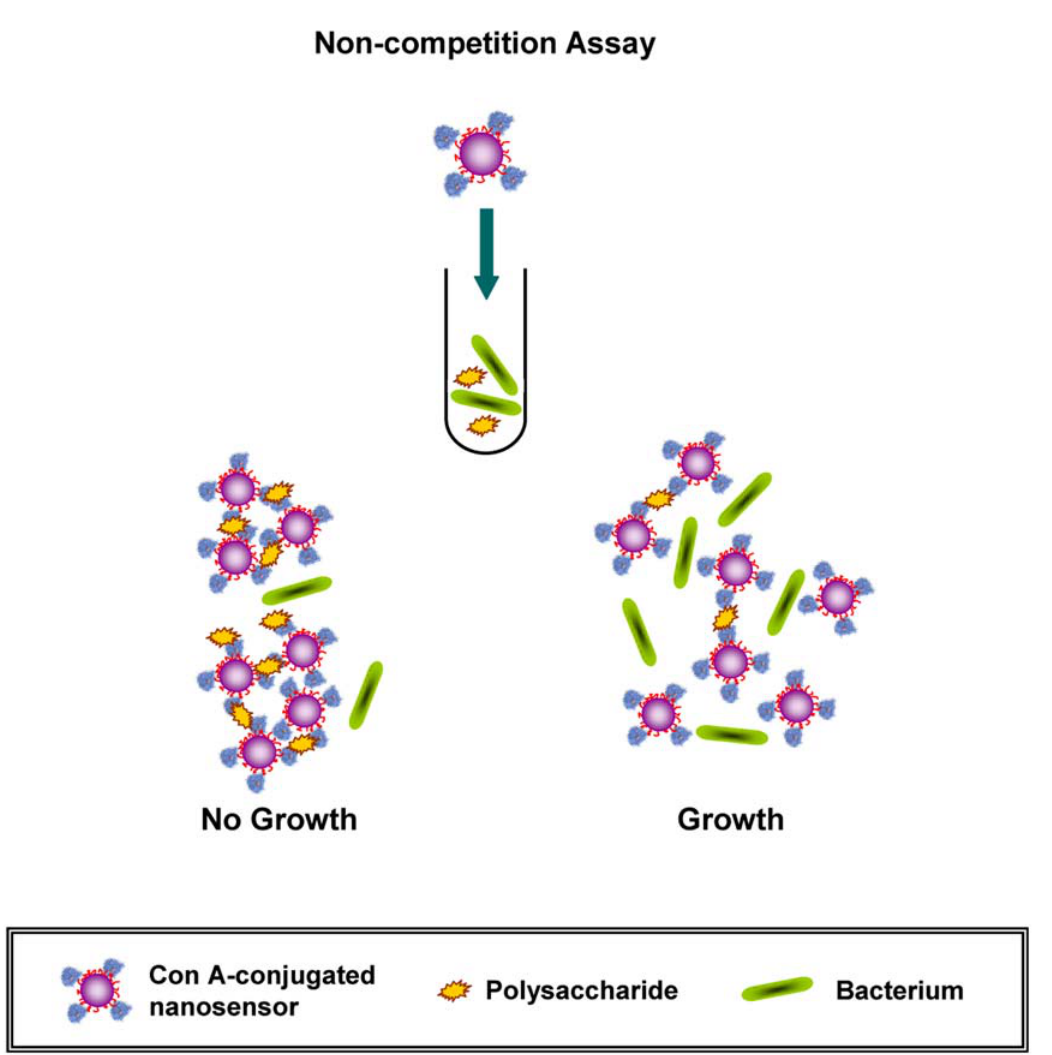
Figure 5. Schematic representation of the assessment of antimicrobial susceptibility using Concanavalin A-conjugated polysaccharide nanosensors. The use of silica-coated nanoparticles and the direct conjugation of Con A to the capping matrix result in a non-competition-based assay format, which may potentially provide faster readout times.